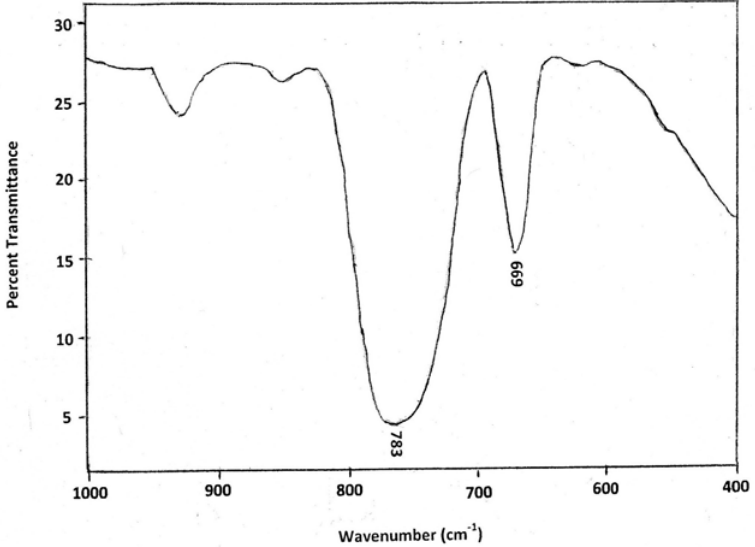
Figure 7. IR spectrum of poly(ethylene glycol dimethacrylate) (PEGDMA).